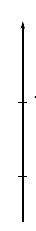
FIG. 5. Loop diagram of the off-resonant stimulated Raman signal TRUECARS. The red arrows represent the fields E 1 , exciting the system, and E (cid:4) 2 , stimulating the emission of the signal photon.